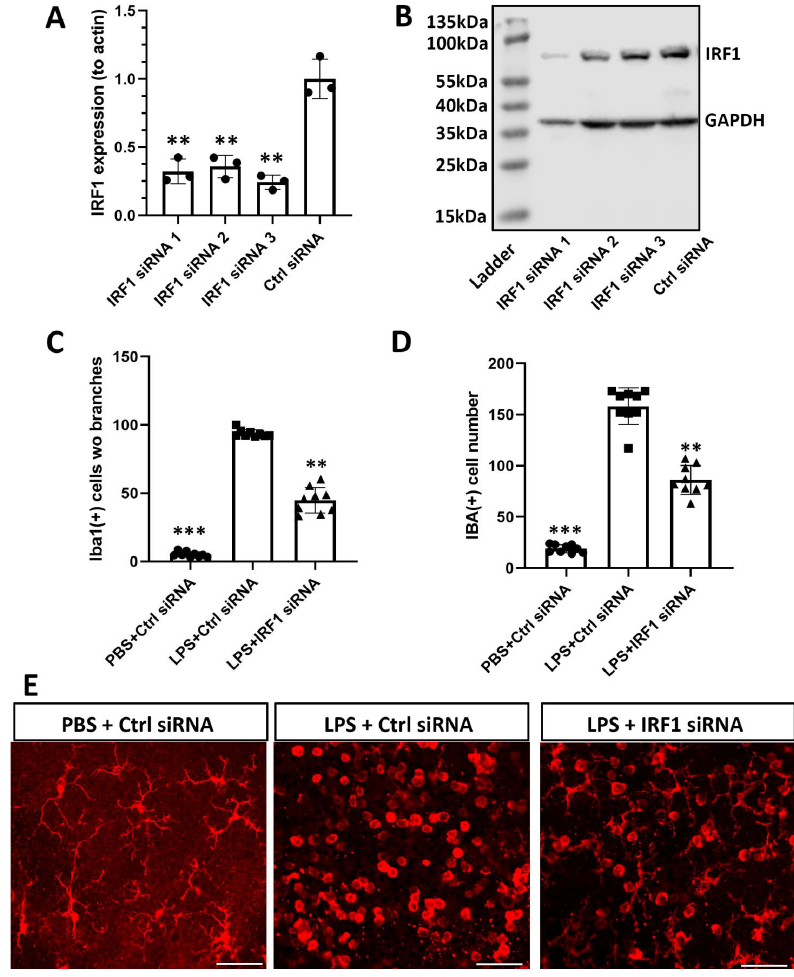
Figure 7. IRF1 knockdown reduces retinal microglia activation in vivo. ( A , B ) The LPS-activated BV2 cells were transfected with three IRF1 siRNAs and scrambled control siRNA (5 nM each). The IRF1 knockdown efficacy of siRNA at the mRNA level by qPCR ( A ) and at the protein level by Western blots ( B ). ( C , D ) The methylated IRF siRNA2 (1 nmol/ µ L, twice) was intravitreally injected into the mouse eyes at 1 and 4 days before LPS injection (100 ng/ µ L, 1 day) for microglial activation. Cell numbers without branches ( C ) and total Iba1 (+) cells ( D ) at the nerve fiber layer and ganglion cell layer (NFL/GCL) were quantified for the three groups: PBS + scrambled control siRNA, PBS + IRF1-siRNA, and LPS + IRF1-siRNA. ( E ) The representative Iba1 (+) cells were taken from the NFL/GCL of three groups. n = 9 areas of interest from 3 independent experiments and biological samples. ** p < 0.01; *** p < 0.001. scale bar = 20 µ